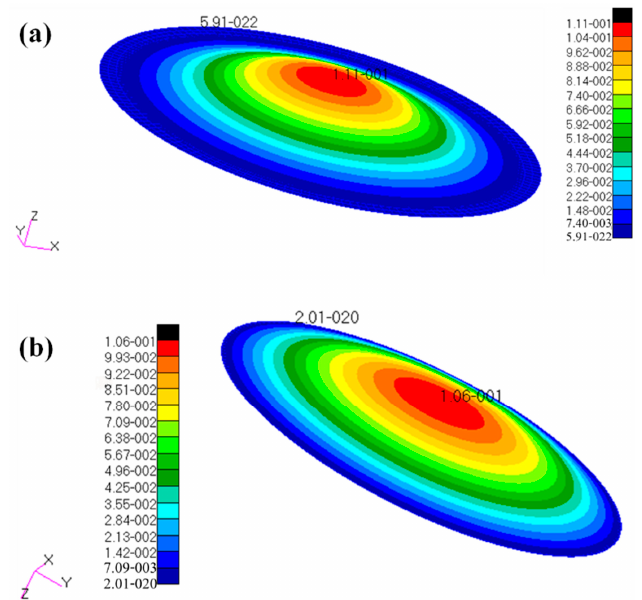
Figure 6. The first-order buckling mode shapes of circular SP-HCs: ( a ) fixed-end supported at the periphery; ( b ) simply supported at the